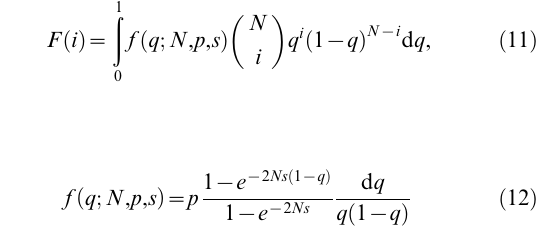
Table S1 Reactions found in the E. coli central metabolic network analyzed in this study